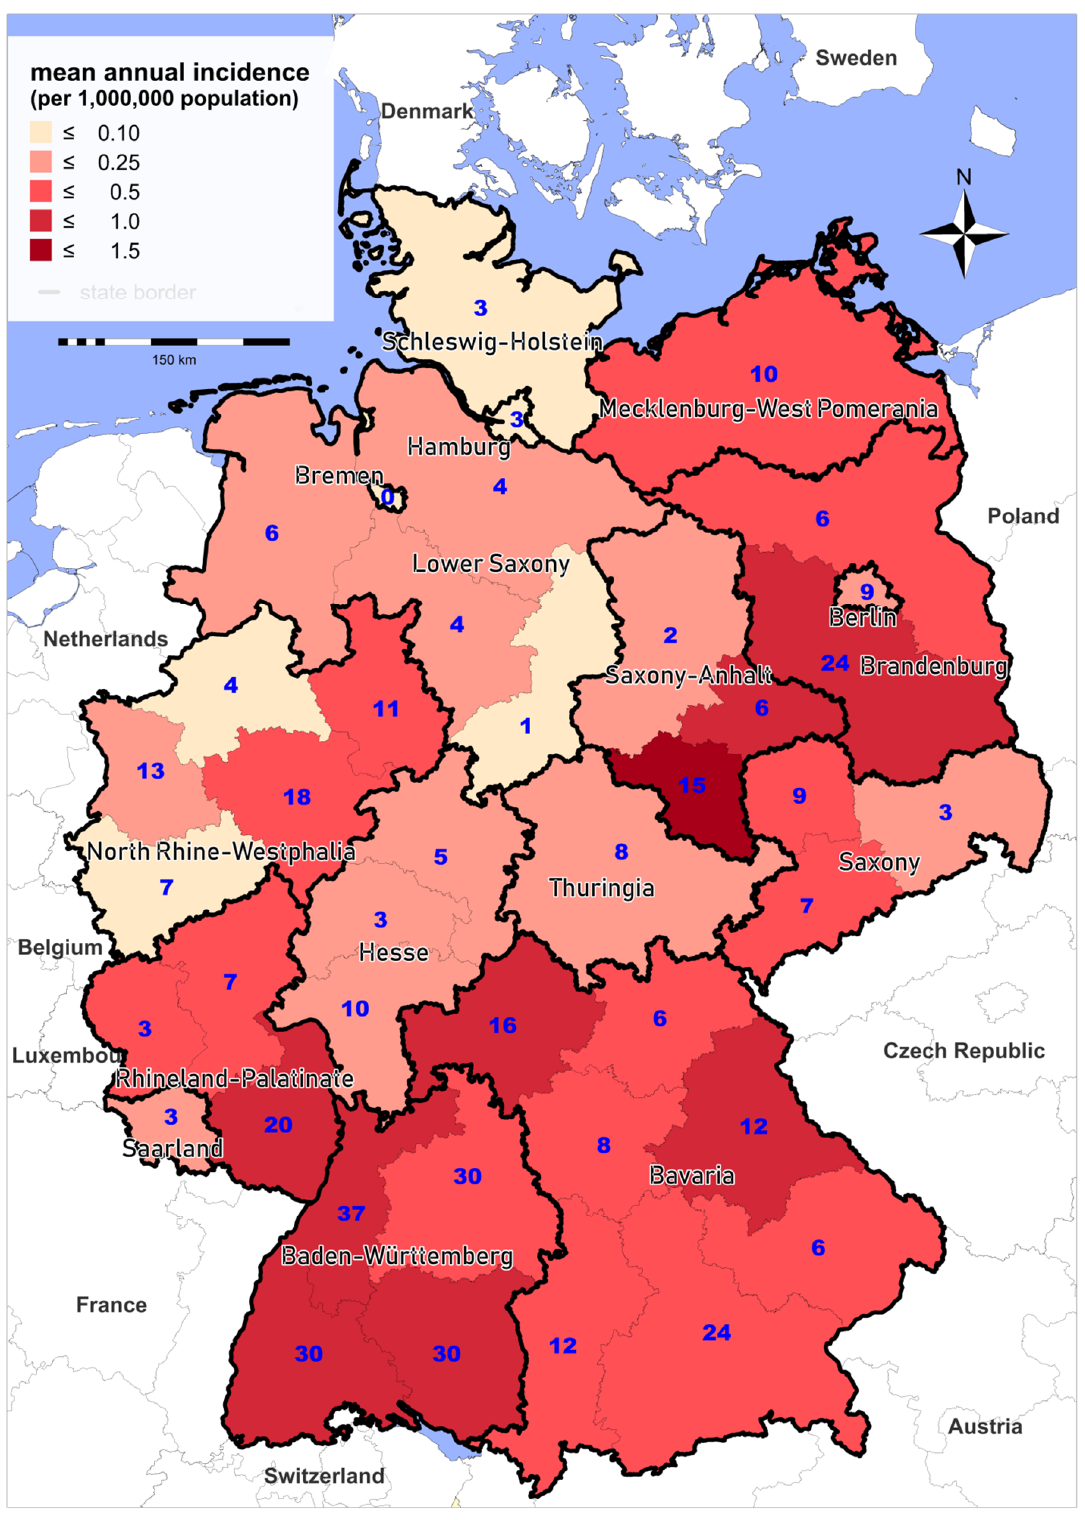
Figure 4. Mean annual incidence (per 1,000,000 population, shading) and total number of notified cases of tularemia (blue digits), Germany, 2002–2019.